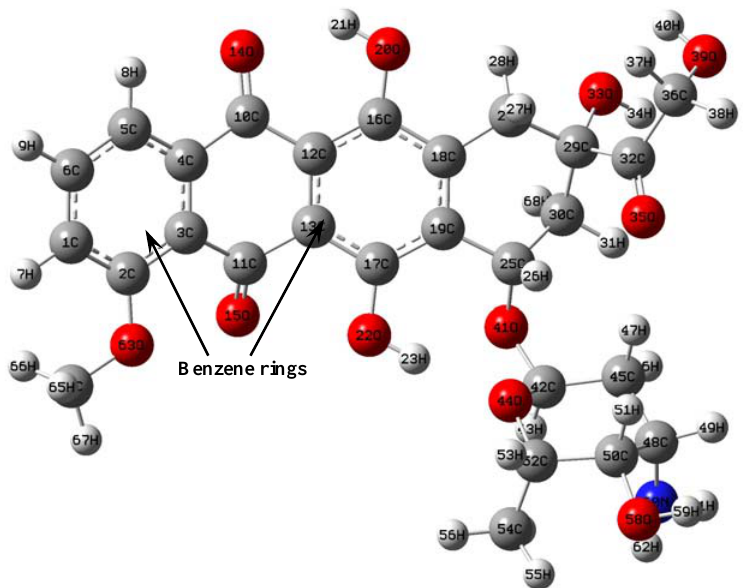
Figure 1. Optimized structure of